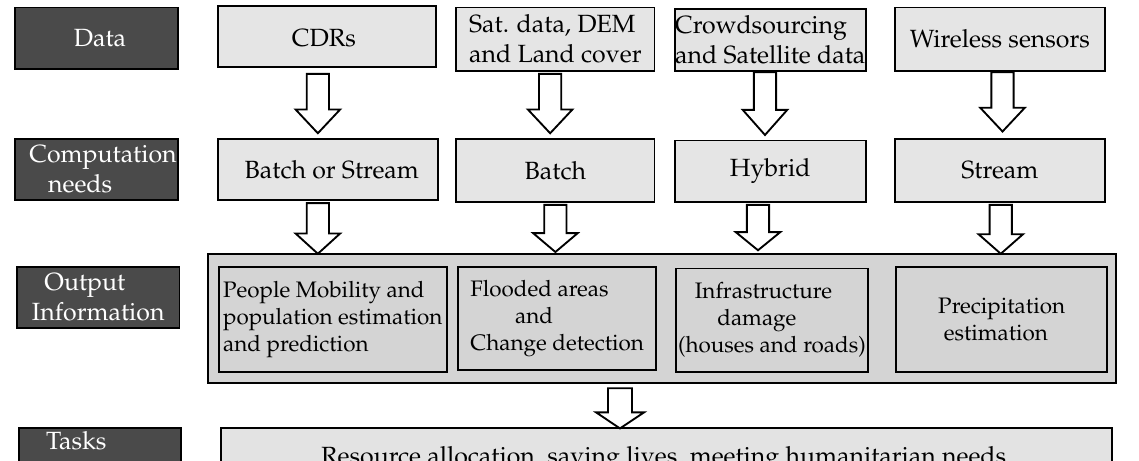
Figure 4. Big data and processing framework for disaster